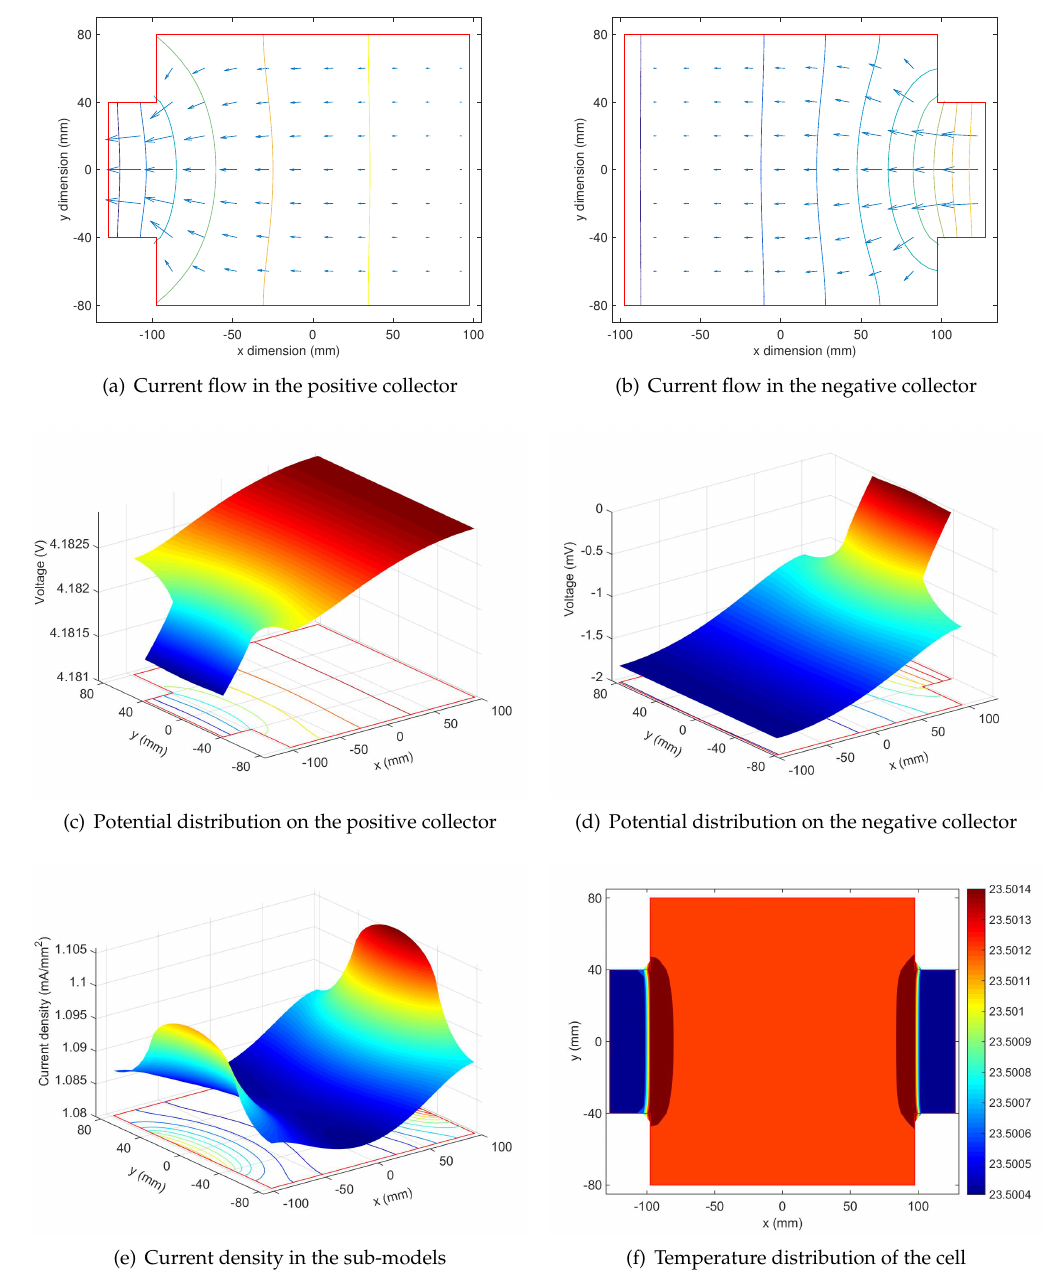
Figure 13. Non-uniformity at the beginning of the 1C